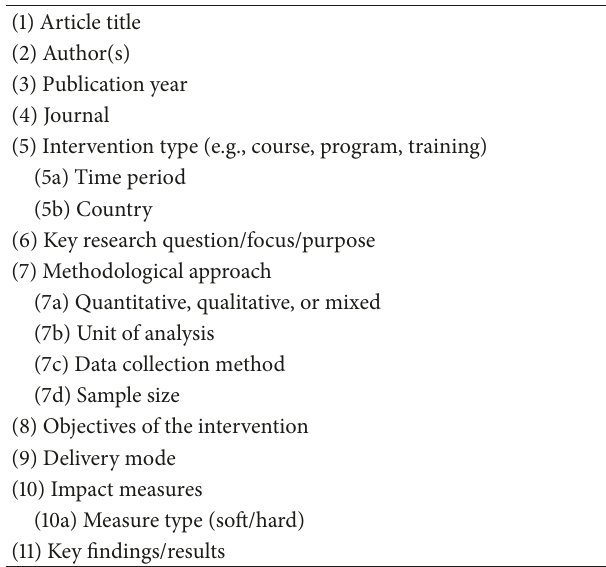
Table 4: Reading